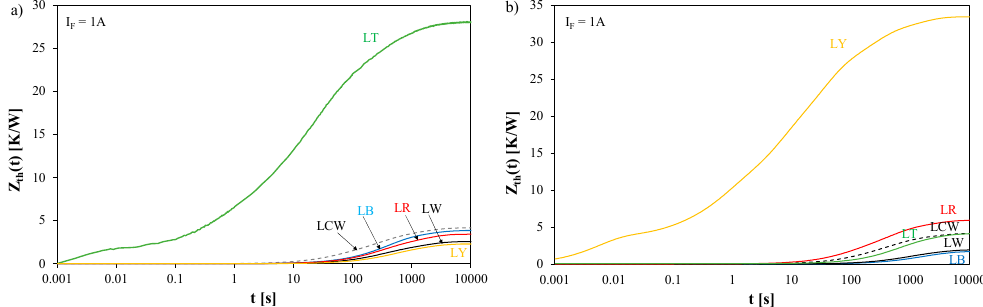
Figure 15. Measured waveforms of self and transfer transient thermal impedances of the tested diodes obtained while heating the LT diode ( a ) or LY diode ( b ).